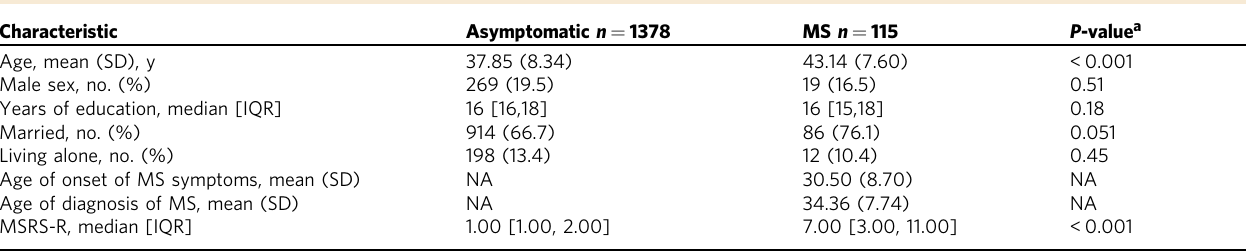
a P -values calculated using t test for age; chi-squared test for female sex, married, and living alone; and Wilcoxon signed-rank test for years of education and MS rating scale score-revised